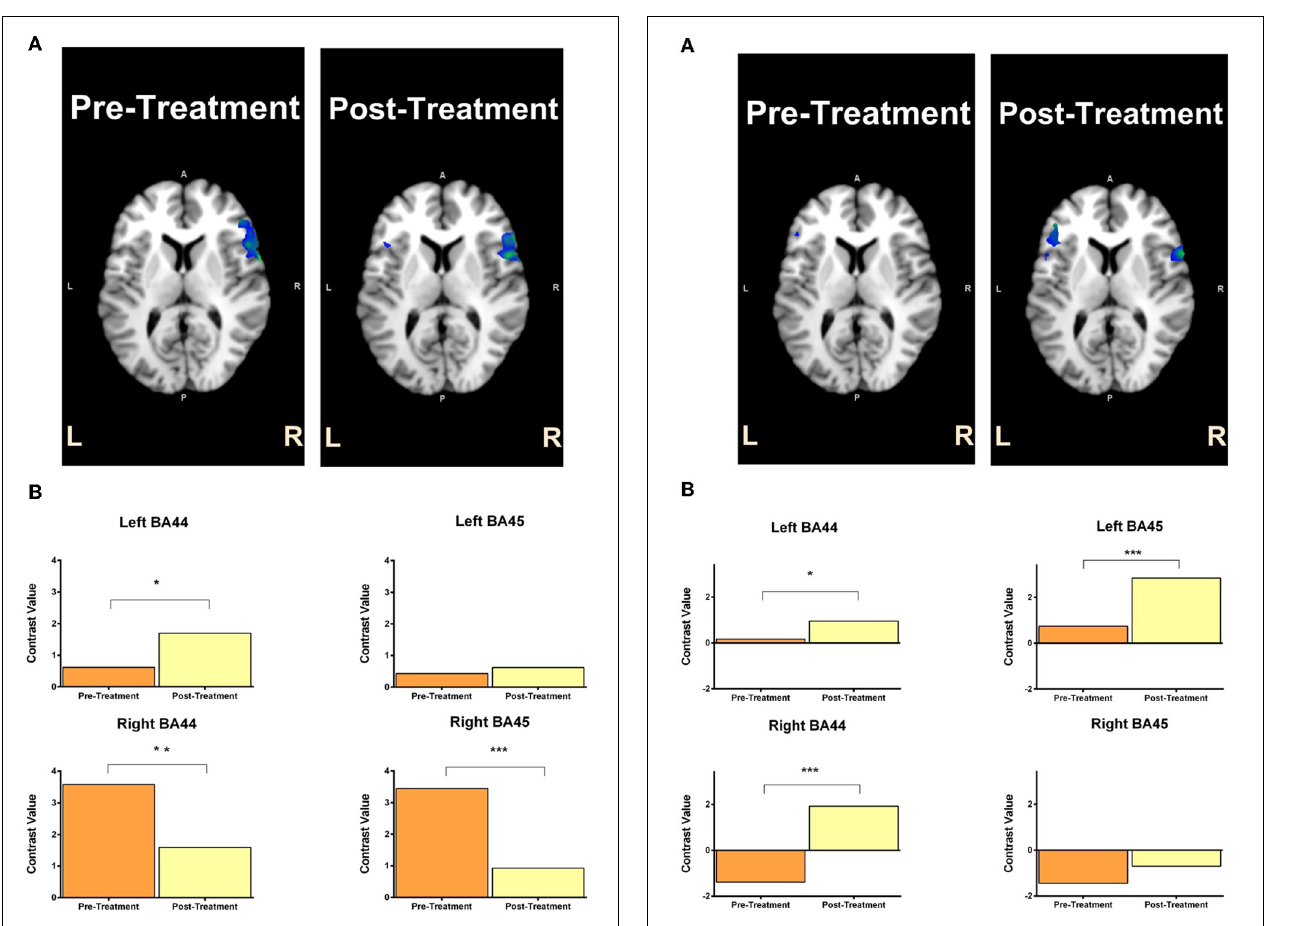
FIGURE 5 | GOE’s statistical activation within the ROI (left Broca’s area and right Broca’s homolog) is shown in panel (A) for the contrast of speaking vs. fixation in the automatic speech task. The reconstructed ROIs for pre-treatment and post-treatment are projected on the axial anatomic background (MNI) reference brain. Panel (B) reflects contrast values related to ROI activity in the pre-treatment and post-treatment scans for GOE (with 95% CI) in the automatic speech task. Contrast value refers to the value of ß in the analyzed contrasts of pre-treatment > post-treatment (top) and post-treatment > pre-treatment (bottom). Asterisk ∗ indicates p < 0 . 05 uncorrected, ∗∗ reflects p < 0 . 01 uncorrected and ∗∗∗ denotes p < 0 . 001 uncorrected.